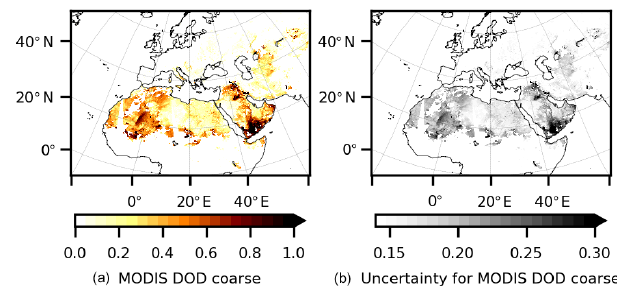
Figure 1. Example of assimilated observations for 9 July 2012: DOD coarse retrieved from the Aqua MODIS DB Level 2 products (Collection 6; a ) and the associated observation uncertainty used in the assimilation algorithm (b) .